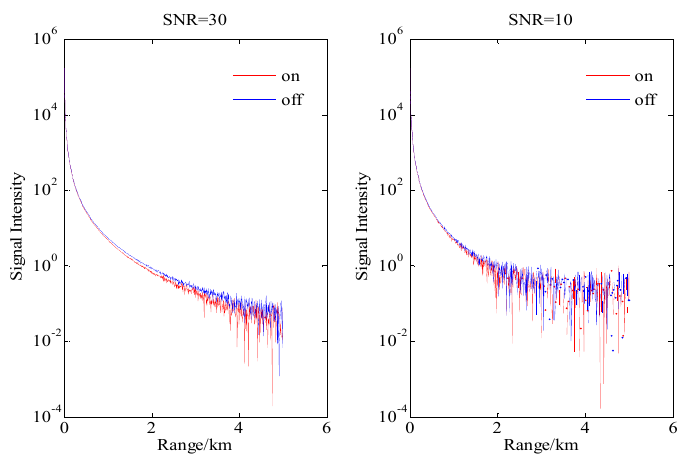
Figure 7. Simulated echo signal of DW-DIAL with SNR of 30 and 10.